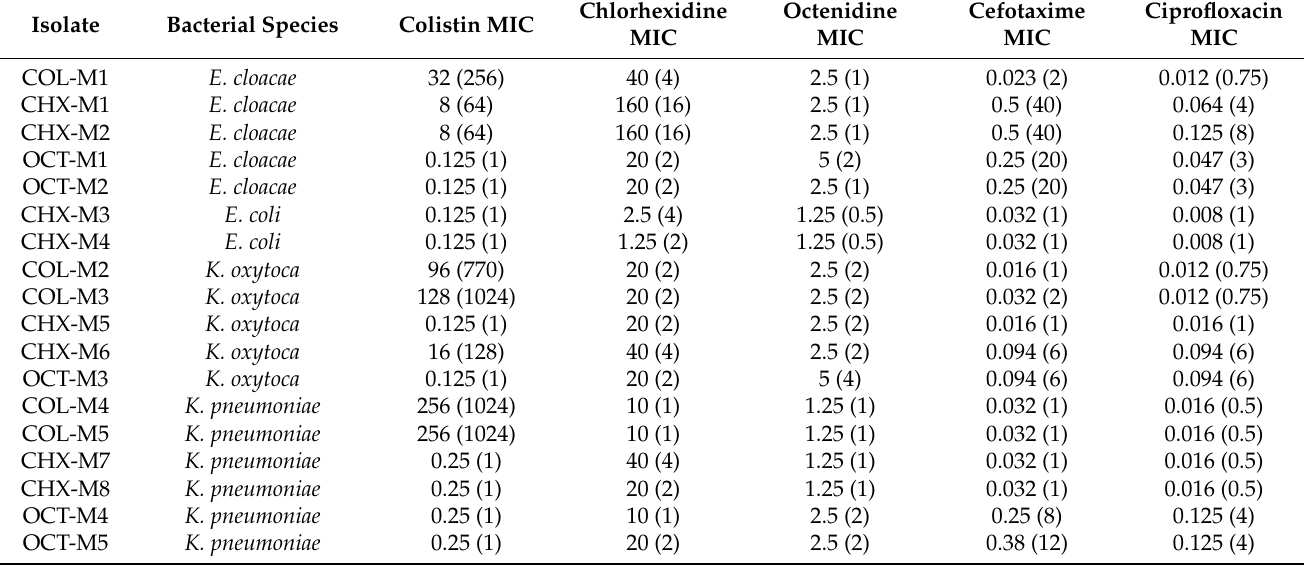
-8OCT-M2OCT-M1OCT-M3OCT-M4 and -5 -4CHX-M6CHX-M5CHX-M7 and -5CHX-M3 -3CHX-M1 COL-M4 and COL-M1COL-M2 and and Figure 2. Representation of ratios of each antimicrobial MIC of each lineage divided by the corre- sponding MIC of the ancestor. The Ratios are represented in logarithmic scale. The mean of the ratios of the MICs of different lineages compared to the ancestor was calculated when these MICs were not significantly different and for lineages in the same media and issued from the same ancestor. Table 2. Susceptibilities to main antiseptics and antibiotics of the lineage compared to the ancestors. The colistin, chlorhexidine, octenidine, cefotaxime and ciprofloxacin minimal concentration inhibition of each lineage are presented in this table. Each MIC corresponded to the mean of 3 MICs determined for each couple of antiseptic or antibiotic/ lineage. In bracket are indicated the ratio of the MIC of the lineage divided by the corresponding MIC of the ancestor. The mean of the ratios of the MICs of different lineages compared to the ancestor was calculated when these MICs were not significantly different and for lineages in the same media and issued from the same